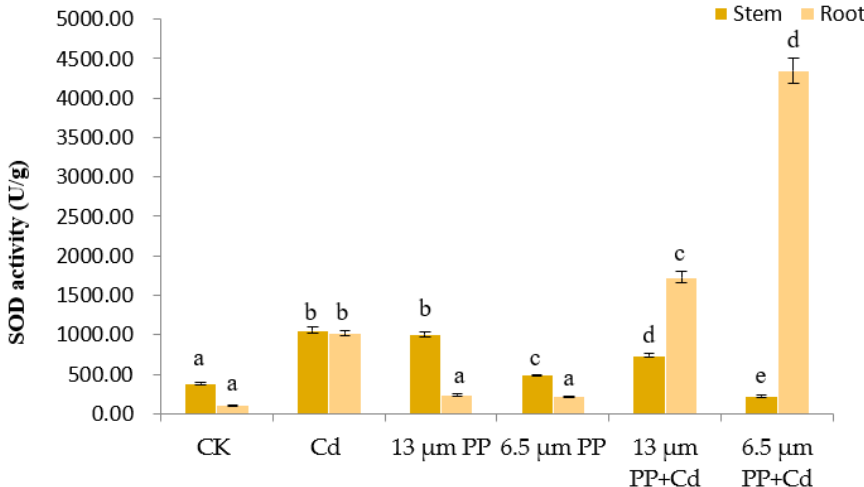
Figure 6. Effect of PP MPs and Cd on superoxide dismutase activity (SOD) of rice seedlings. Results are shown in mean ± SD ( n = 9). Different lowercase letters a, b, c, d and e represent a significant difference between different treatments groups at the same MP particle size or at the same cadmium concentration (at p ≤ 0.05), whereas the same letters indicate insignificant differences between treatments. Where CK—Control check; Cd—Cadmium; PP—Polypropylene.